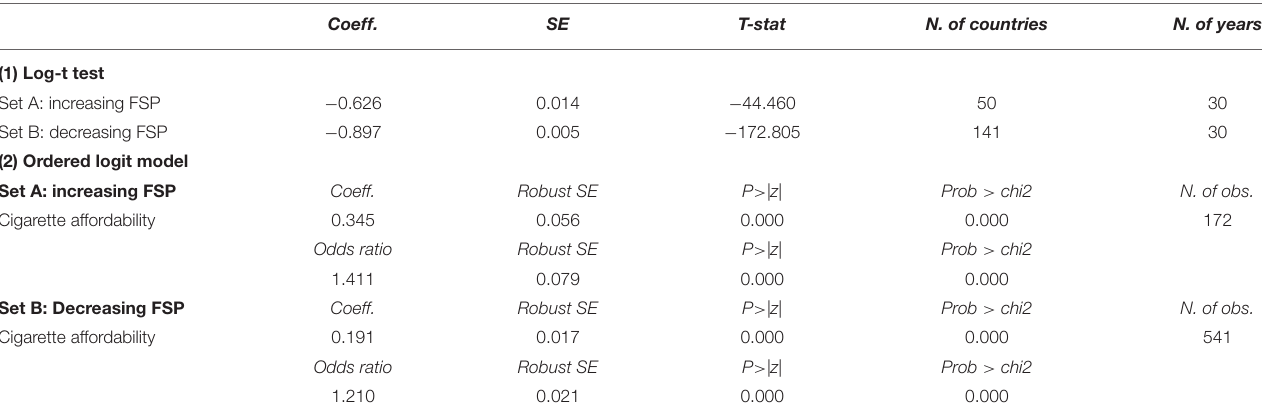
TABLE 1 | Results of (1) the log-t test, and (2) the ordered logit model.